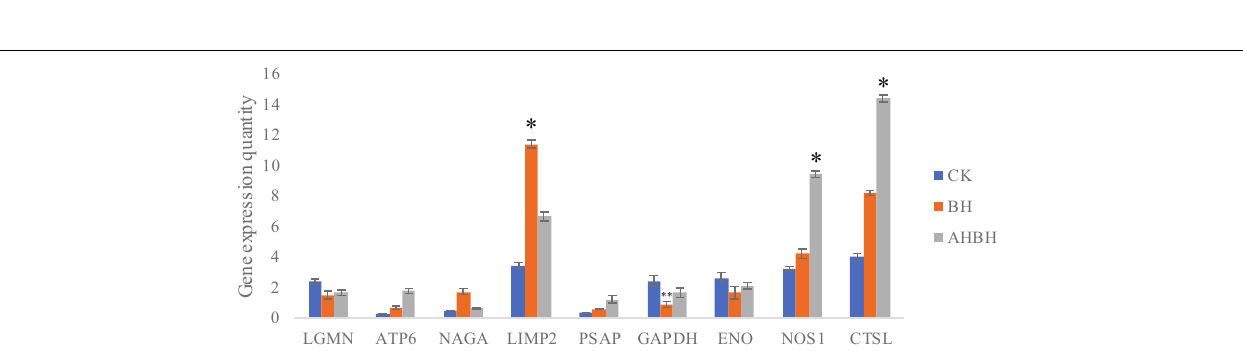
FIGURE 7 | Transcriptome gene expression in gill tissues from C. japonica . CK, control group; BH, C. japonica immersed in berberine hydrochloride; BHAH1, C. japonica immersed in berberine hydrochloride and injected with A. hydrophila . Error bars represent standard deviations of three independent repeats. ∗ p < 0.05, ∗∗ p < 0.01 analyzed by t -tests. Four crabs were used in each group.